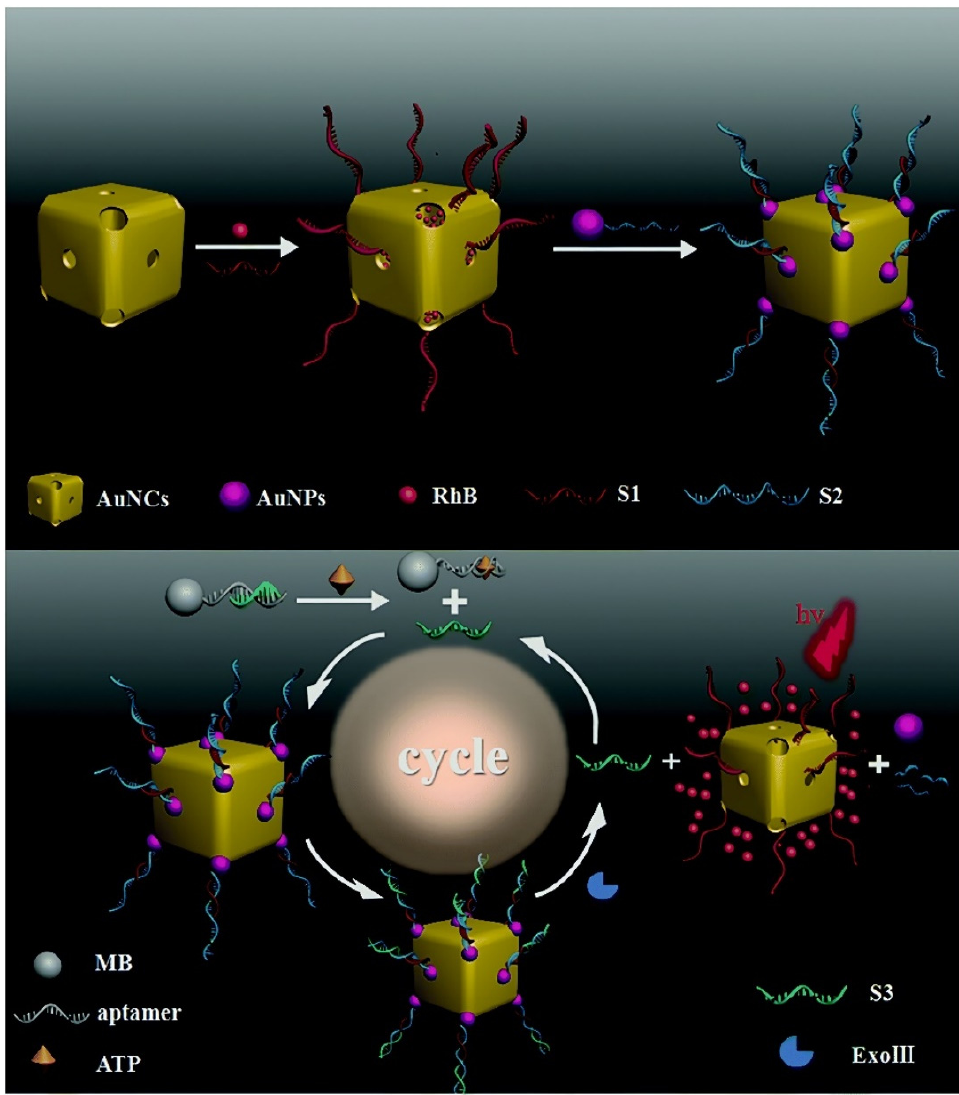
Figure 13. Schematic illustration of the AuNC-based ATP- and enzyme-responsive biosensor system for the detection of ATP. Reprinted/adapted with permission from Ref. [103]. Copyright 2020, The Royal Society of Chemistry.